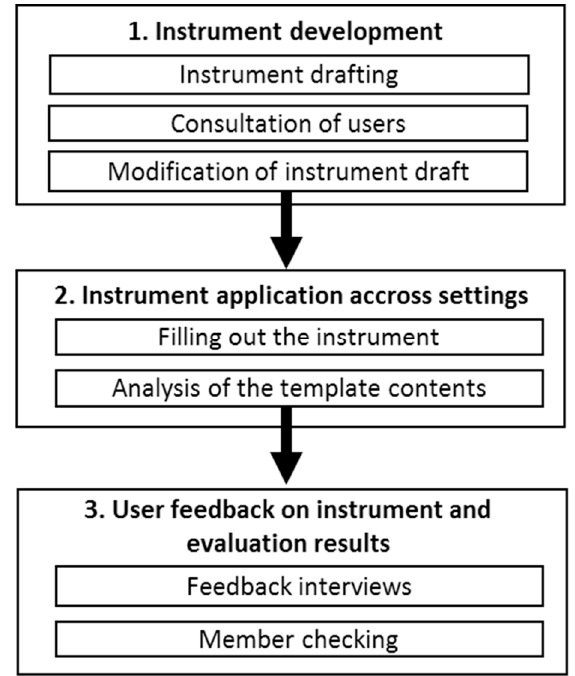
Figure 1. Flow chart of the instrument development process.